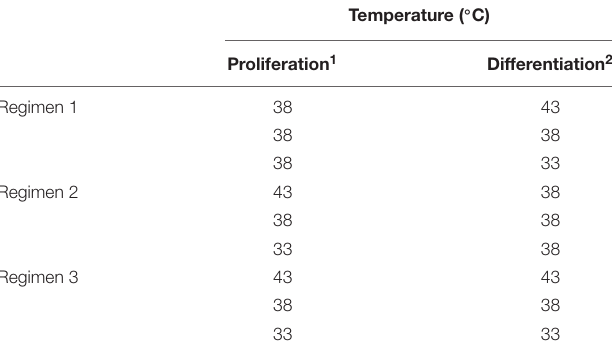
TABLE 1 | Incubation strategies during satellite cell proliferation and